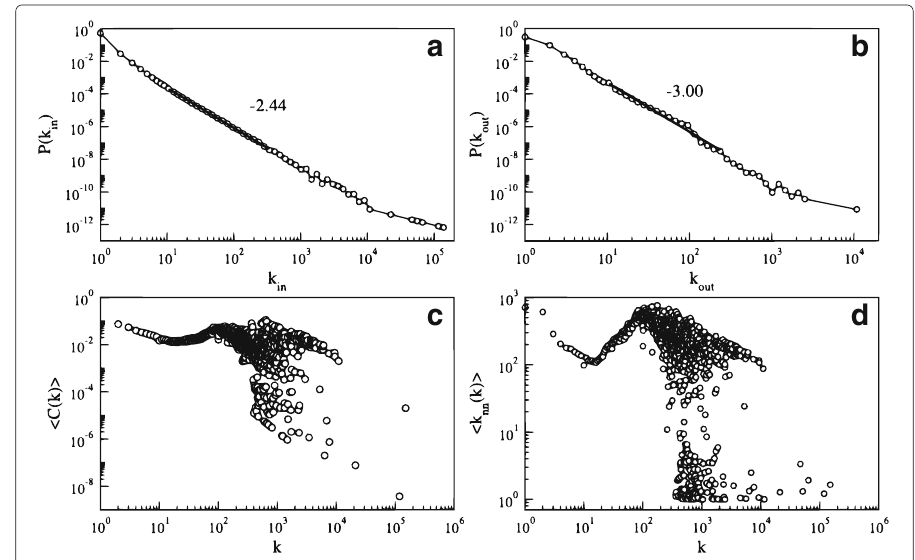
Fig. 6 Structural properties of the GON. The probability density distributions P for nodal a in-degree k in and b out-degree k out . Solid lines indicate best power law fit to the data. c The average clustering coefficient (cid:5) C ( k ) (cid:6) is plotted with total degree k . d The variation of average nearest neighbor degree (cid:5) k nn ( k ) (cid:6) is shown as a function of nodal degree k . Logarithmic binning of the data is used in ( a ) and ( b )